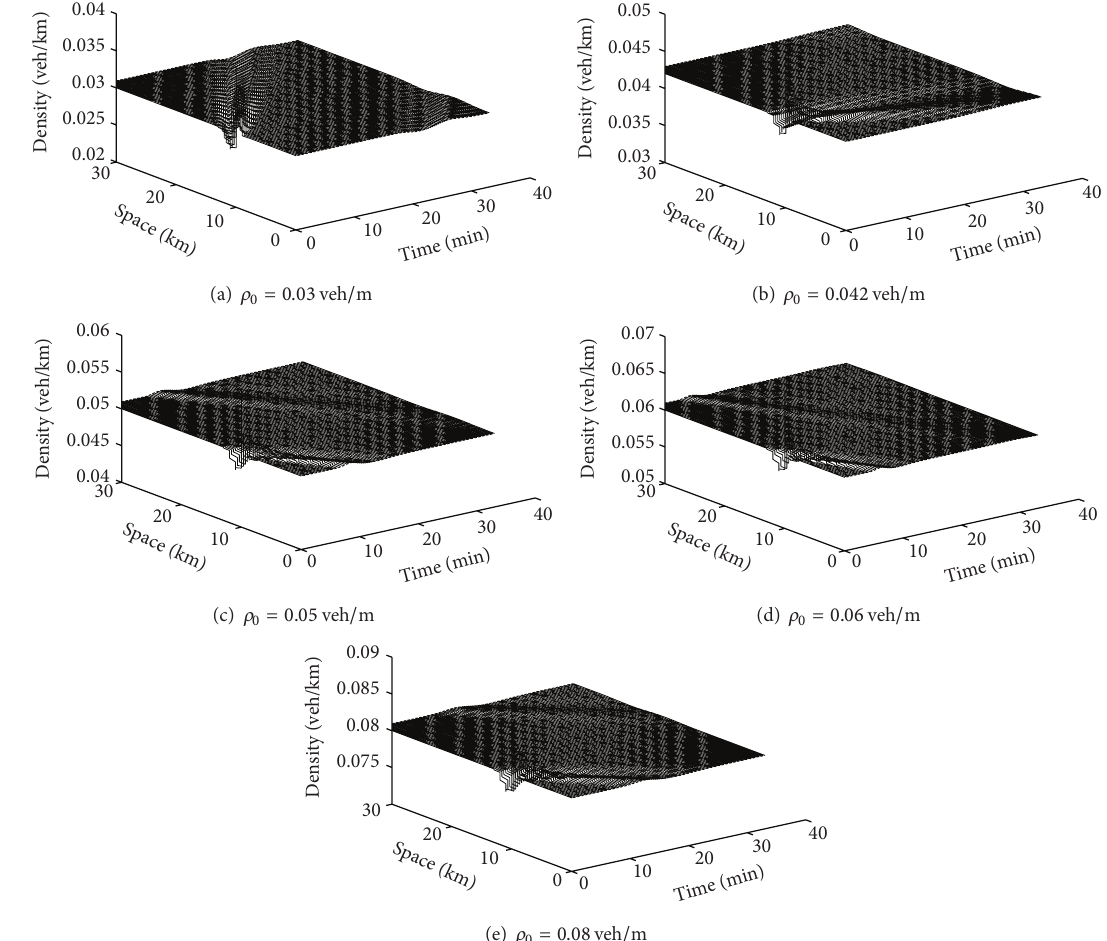
Figure 2: Temporal evolution of traffic flow before 40 minutes for different 𝜌 0 with 𝛽 = 0.4